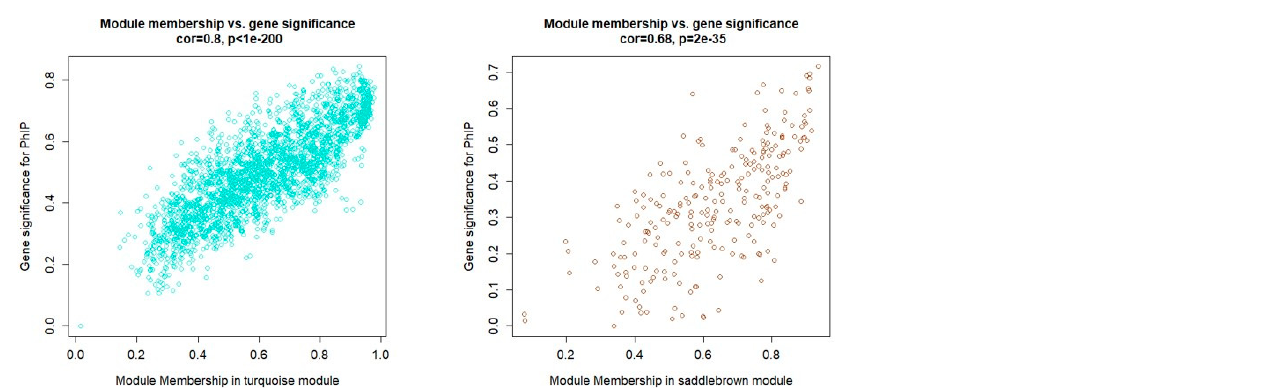
Figure 2. The scatterplot of gene significance for weight vs. module membership in the purple, darkolivegreen, turquoise, saddlebrown, and salmon modules. The correlation was calculated with the absolute value of gene significance and module membership, which illustrates the association between genes and the trait.